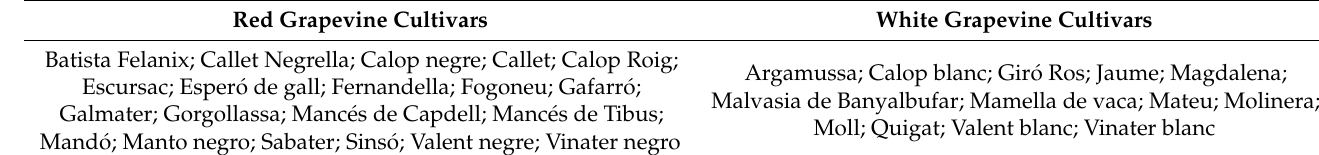
List of cultivars located in the government Grapevine Germplasm Bank of the Balearic